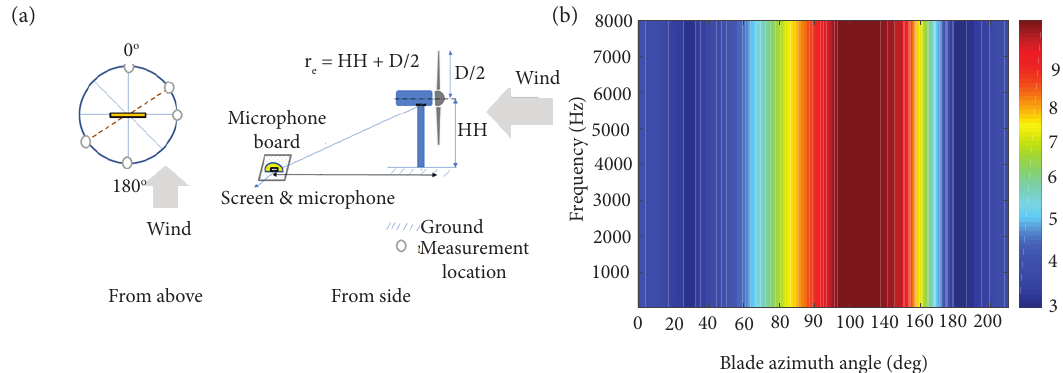
Figure 6. (a) Illustration of plan and side views of observer azimuth position and distance of receiver location from turbine according to IEC61400-11 standards. Horizontal bar represents the rotor plane and dashed line across rotor plane shows location of 60° and 240° observer positions; (b) difference in sound power level (Δ dBA) between 60° and 240° observer positions for an isolated